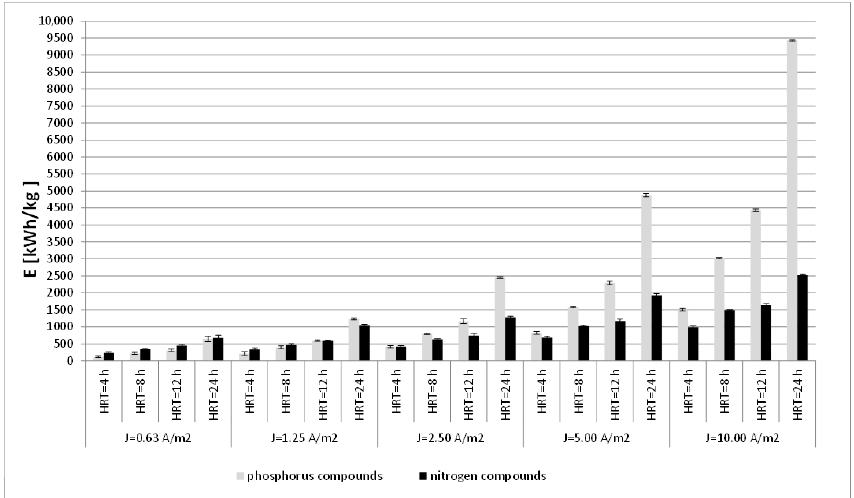
Figure 3. Electric energy consumption per unit of removed TN and TP load in aerobic REBDC.